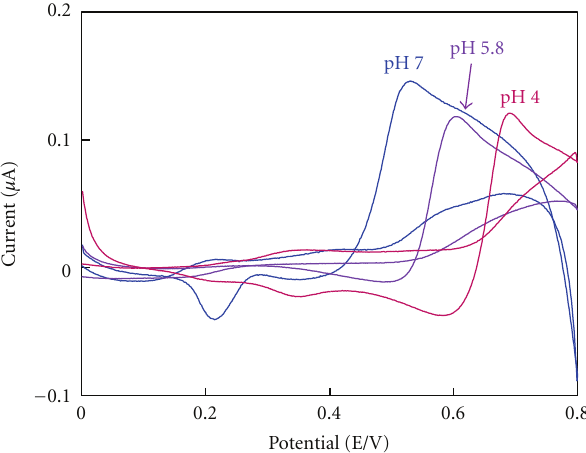
Figure 3: E ff ect of pH to the anodic oxidationof bisphenolA. Cyclic voltammogram of 0.02mM bisphenol A. scan rate 0.1V/sec.